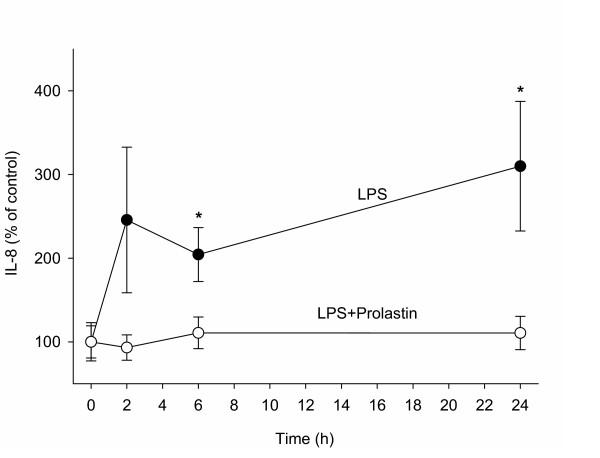
IL-8 analysis in nasal lavage of subjects challenged with LPS alone or LPS+Prolastin combination. Seven healthy volunteers were treated with LPS (25 μg/nostril) or with LPS followed 30 min later with Prolastin (2.5 mg/nostril), nasal lavage was collected at different time points (0, 2, 6 and 24 h) as described in Material and Methods. The concentration of IL-8 (pg/ml) was measured by ELISA. IL-8 values are expressed as a ratio of IL-8 concentration at selected time point and the basal level. Independent two sample t-test shows after 6 and 24 h significantly higher levels of IL-8 in subjects treated with LPS compared to LPS+Prolastin. * p < 0.05